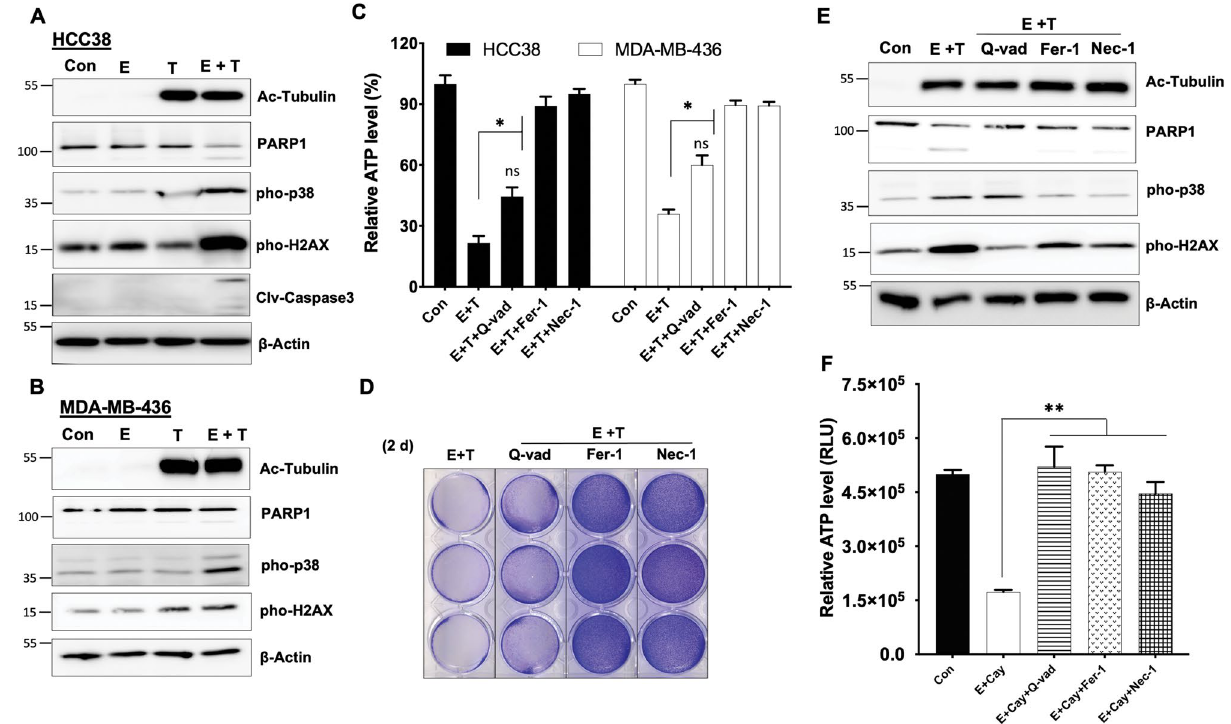
Figure 2. HDAC6 inhibitors synergize with erastin to induce a mixed type of cell death. (A,B) Immunoblot analysis of acetylated-tubulin, PARP1, cleaved Caspase-3, phosphorylated p38, and H2AX protein expression in HCC38 cells ( A ; 24 h) and in MDA-MB-436 cells ( B ; 36 h) under either control (Con), 5 μM erastin (E), 5 μM tubacin (T), or combination of erastin and tubacin (E + T) treatments; β-Actin serves as a protein normalization control. (C, D) Relative cell survival of HCC38 (48 h) and MDA-MB-436 (72 h) were measured by CellTiter-Glo assay ( C; n = 3; *p < 0.001) or assessed by crystal violet staining in HCC38 ( D ) under either Con, combination of E + T, or E + T with different cell death inhibitors Q-Vad (10 μM), Fer-1(10 μM), Nec-1 (20 μM) treatments for 48 h. ( E ) Immunoblot analysis of indicated protein expression in HCC38 cells treated as ( C ) for 24 h. (F) Relative cell survival of HCC38 cells under either control (Con), combination of erastin and 2 μM Cay (E + Cay), or E + Cay with following death inhibitors Q-Vad 10 μM, Fer-1 (10 μM; **p < 0.005), Nec-1 (20 μM; **p < 0.005) treatments for 48